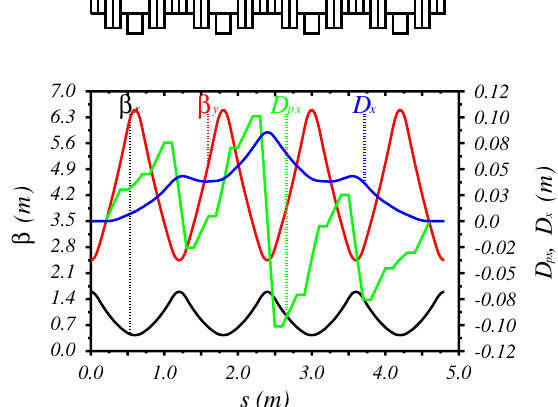
FIG. 3. First order dispersion and beta functions of one super- cell which consists of four identical FODO cells: black curve denotes horizontal beta function, red curve denotes vertical beta function, blue curve denotes horizontal dispersion function, and green curve denotes horizontal angular dispersion function. The color notation is the same for the first-order optics in the following